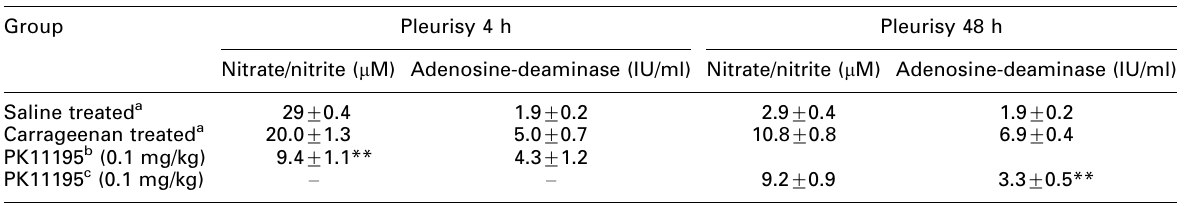
The parameters were analysed 4 and 48 h after the administration of either carrageenan or buffered-saline in the pleural cavity. Values represent the mean 9 / standard error of the mean (n (cid:3) / 4 (cid:1) / 6 animals per group). Statistical differences determined by analysis of variance, complemented with Dunnett ? s test are indicated: ** p B / 0.01. a Treatment given to the pleural cavity. b Treatment given by i.p. route, 1 h before carrageenan. c Treatment given by i.p. route with two doses of PK11195 of 0.1 mg/kg with a 12 h